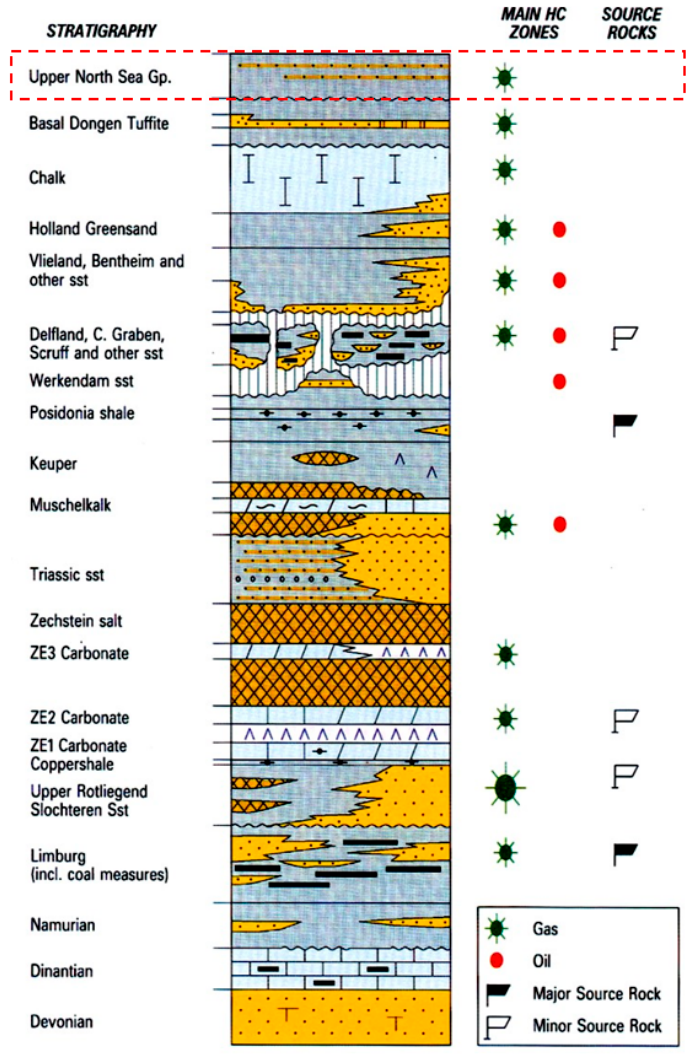
Figure 5. The hydrocarbon plays and stratigraphy of the North Sea Basin. The Upper North Sea Group is the zone of interest for this study. After Rondeel, Batjes and Nieuwenhuijs [40].